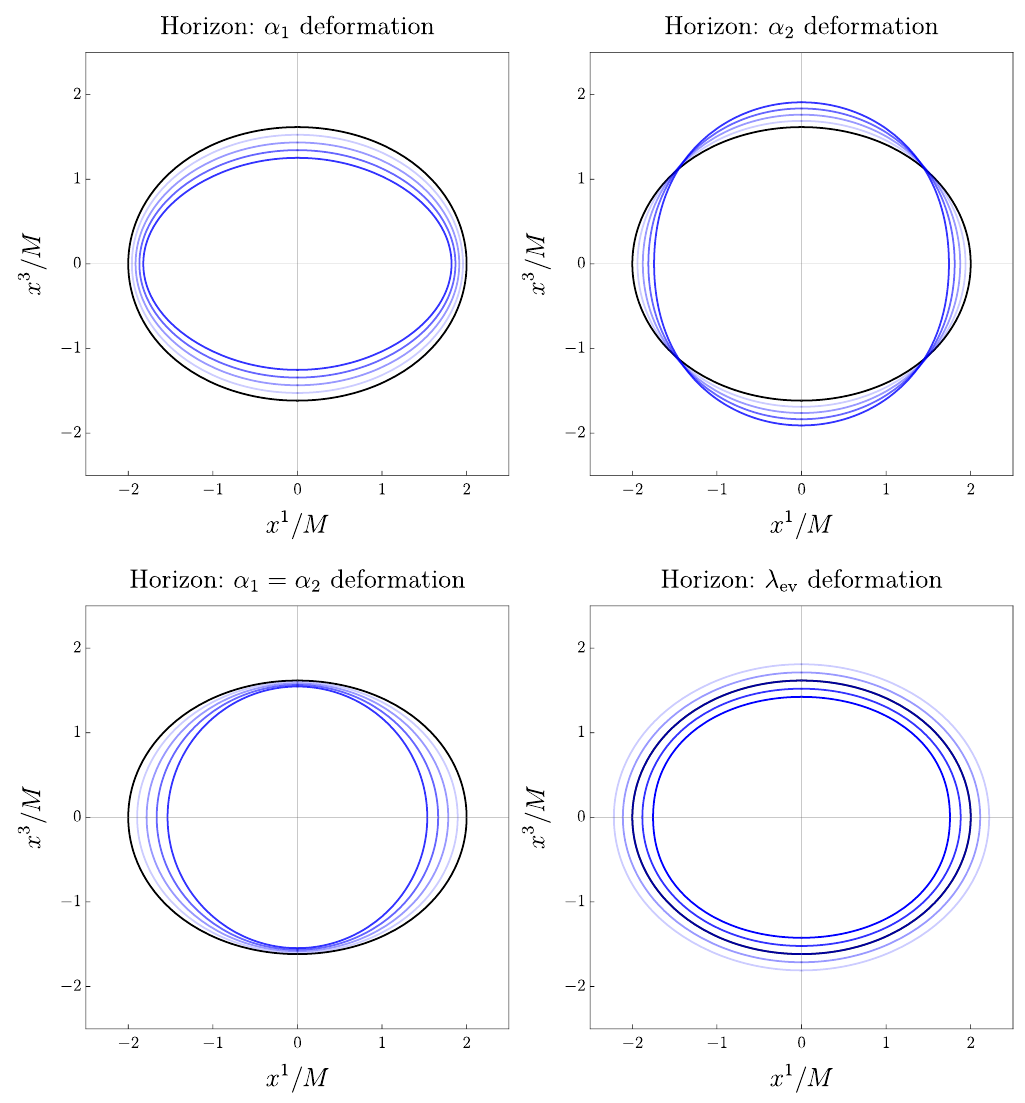
Figure 4 . Isometric embedding of the horizon in E 3 for di(cid:11)erent values of the parameters and for (cid:31) = 0 : 65. In black we represent the horizon of Kerr black hole and in blue the horizon of the corrected solution for a (cid:12)xed mass and di(cid:11)erent values of the couplings. From light to darker blue we increase the value of the corresponding coupling. In each case, only the indicated couplings are non-vanishing. Top left: ‘ 4 (cid:11) 2 = 0 : 05 ; 0 : 1 ; 0 : 15 ; 0 : 2, top right: ‘ 4 (cid:11) 2 = 0 : 05 ; 0 : 1 ; 0 : 15 ; 0 : 2, bottom 1 2 M 4 M 4 left: ‘ 4 (cid:11) 2 = ‘ 4 (cid:11) 2 = 0 : 05 ; 0 : 1 ; 0 : 15 ; 0 : 2, bottom right: ‘ 4 (cid:21) ev = (cid:0) 0 : 4 ; (cid:0) 0 : 2 ; 0 : 2 ; 0 : 1 2 M 4 M 4 M 4